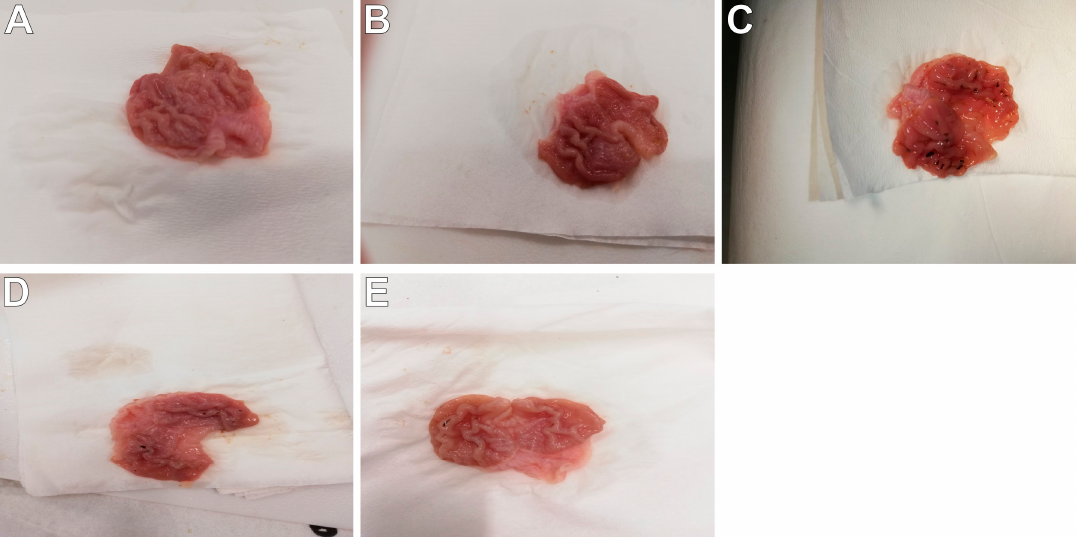
Figure 5. Macroscopic appearance of the gastric mucosa demonstrated that studied compounds caused negligible mucosal lesions. Morphine and indomethacin were used as reference drugs. Experimental groups ( n = 12): Control group ( A ); group receiving 10 mg/kg morphine ( B ); group receiving 10 mg/kg indomethacin ( C ); group receiving 20 mg/kg compound 10b ( D ); group receiving 20 mg/kg compound 13b ( E ).